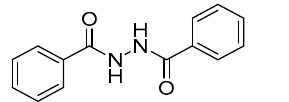
Figure 1. DBH structural formula. Aromatic hydrogens are omitted for the sake of clarity.